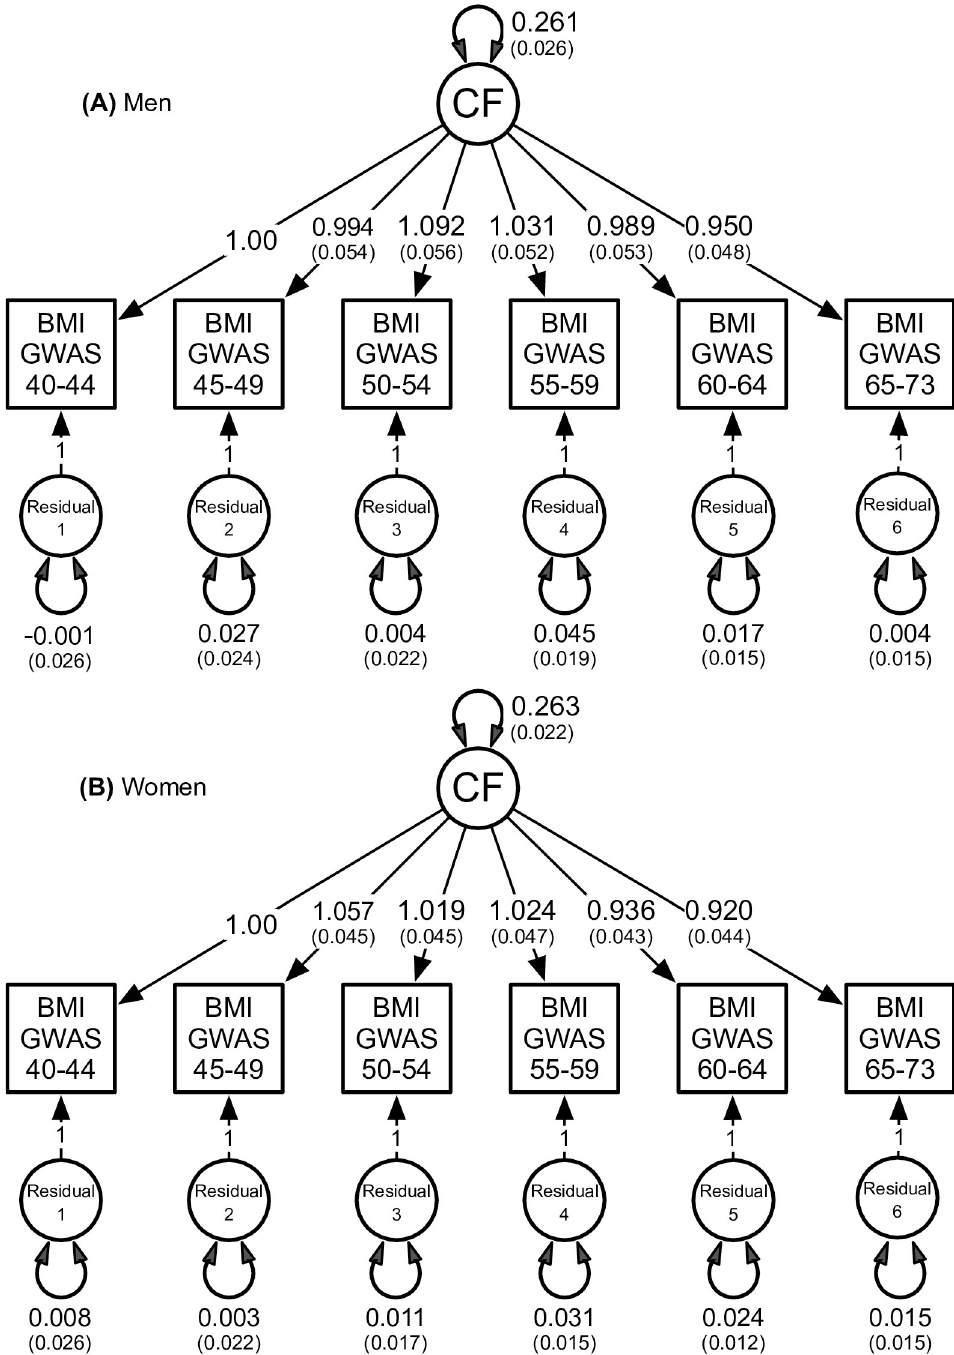
Fig 3. Best fitting factor analytic model with a single common factor (CF) for men (A) & women (B ) . To identify this model, the first factor loading from the CD to BMI GWAS at 40–45 years was constrained to one. The double- headed arrow on the CF denotes the standardized variance, or SNP-based heritability, for BMI. Double-headed arrows on the residuals denote genetic variation at each age interval not otherwise explained by the CF.